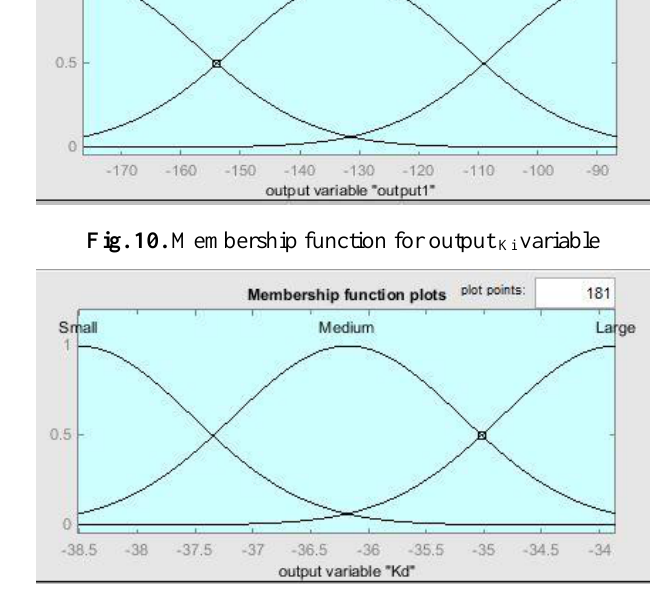
Fig. 11. Membership function for output K d